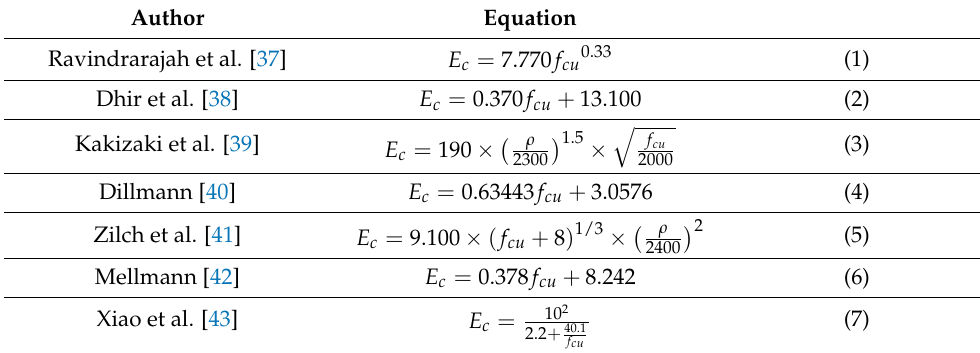
Table 6. Equations that correlate elastic modulus with cubic compressive strength of